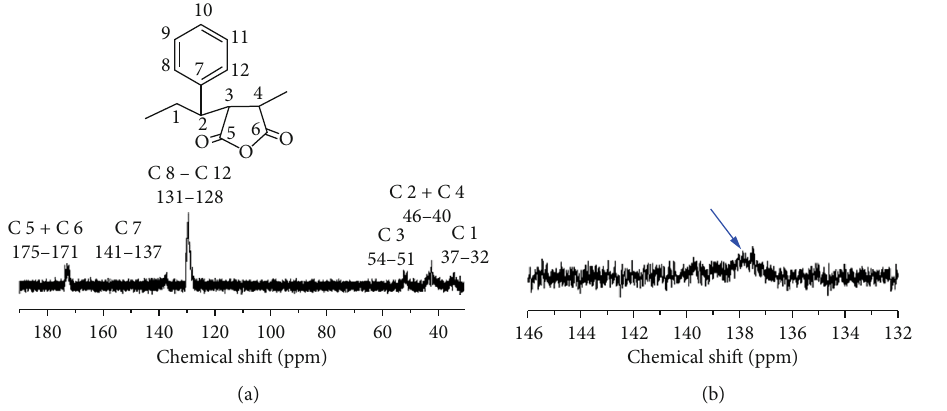
M M : 30 ) obtained from RAFT copolymerization of St and MAh initiated by n = 19100 , w / n = 1